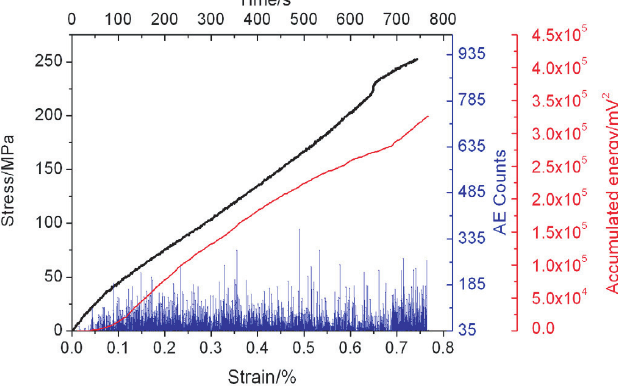
Fig. 1. Typical tensile stress-strain curve of a 2D C/SiC CMC with real-time acoustic emission signals.